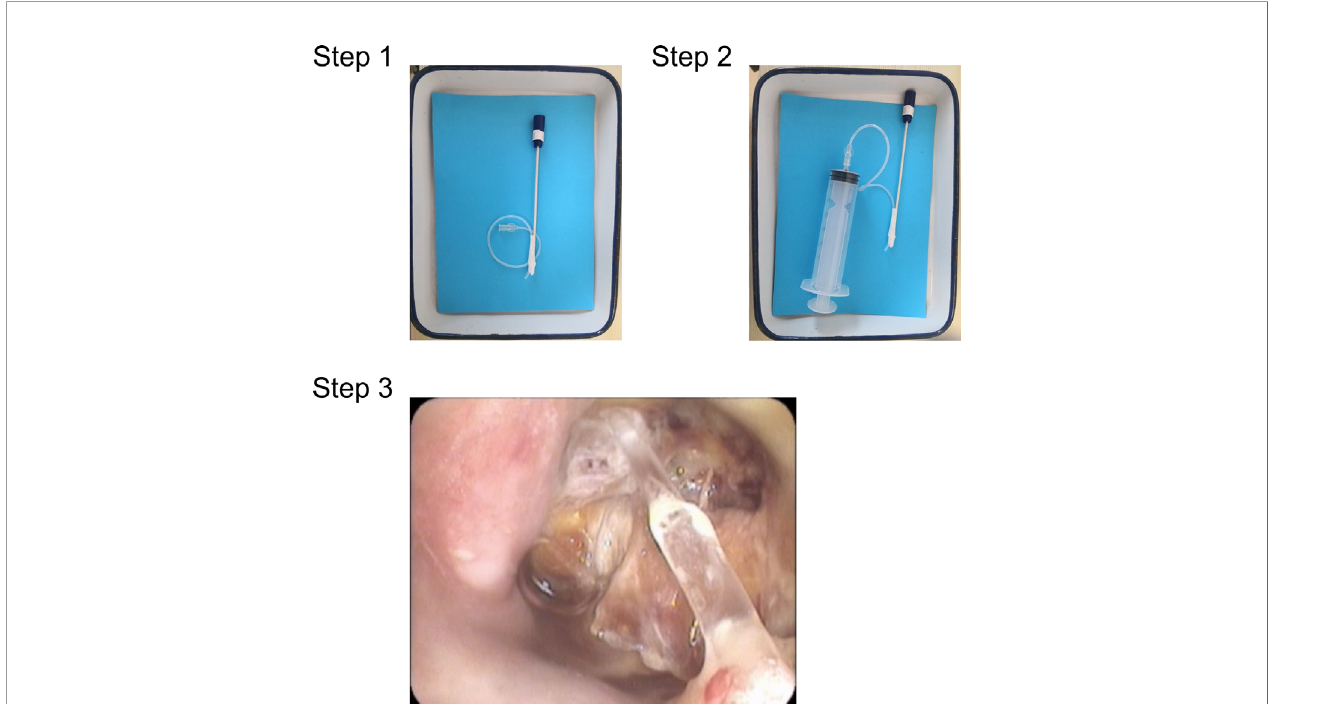
FIGURE 2 | Modi fi ed irrigation device and usage. Step 1: a connecting tube of the infusion is attached to a wooden throat swab stick. Step 2: a 50-ml syringe is connected to the connecting tube to form the self-made nasopharyngeal irrigation device. Step 3: the device is used to irrigate the PRNN